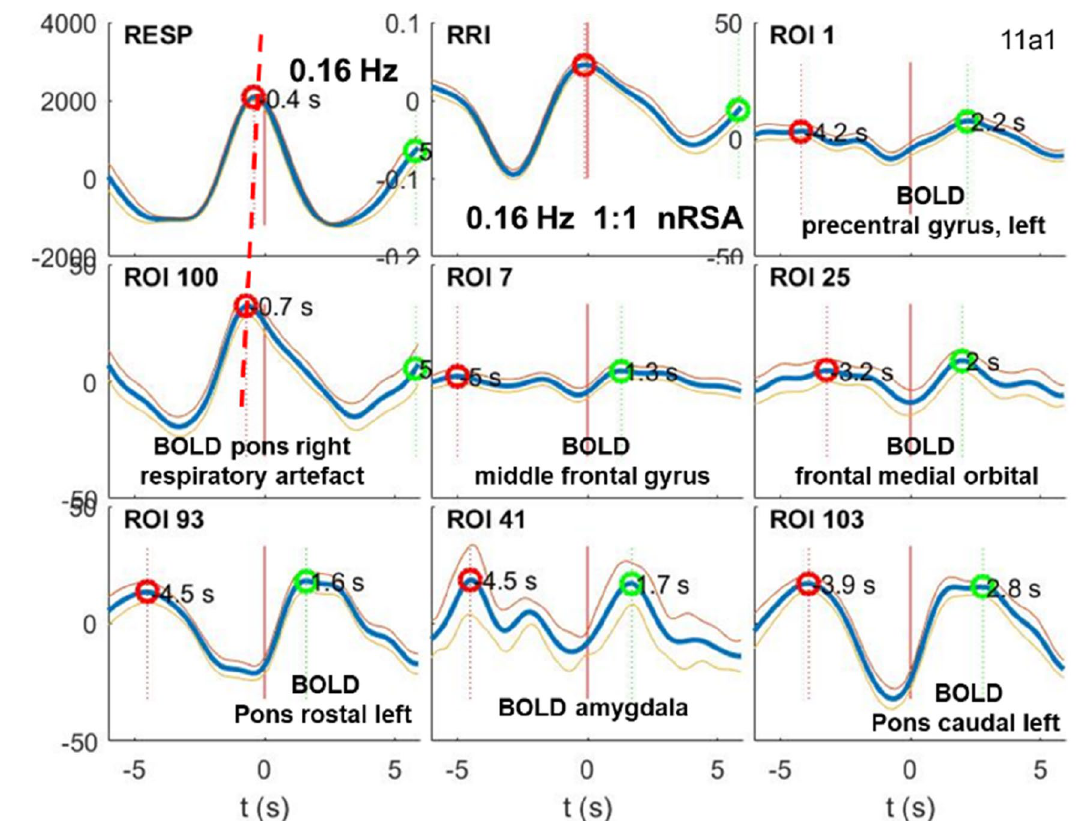
Figure 3. Examples of RRI peak triggered breathing and BOLD waves from a normal subject with high fMRI- related anxiety. For further explanation see Fig. 2. The data are from the first half of recording with dominant 0.16 Hz oscillations (in the second half dominated the 0.1 Hz oscillations were prevailing) and precise waves with period s of 6.2 s in